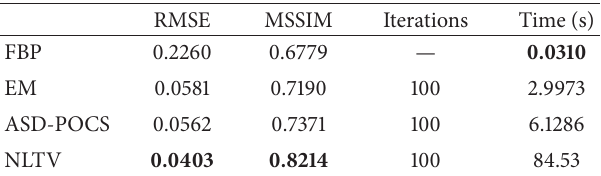
Figure3: Reconstructionresultsof chestimageby differentmethods. (a)Original, (b)FBP,(c)EM,(d)ASD-POCS, (e)NLTV,and (f)zoomed parts of original image, ASD-POCS, and NLTV. First row is original images, the second row is ASD-POCS results, and the third row is NLTV results. Table 2: Evaluations of clinical image